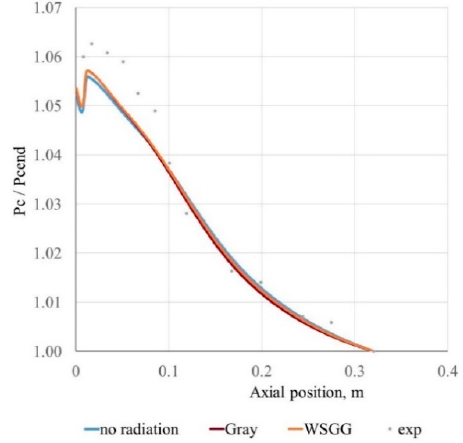
Figure 8. Normalized axial pressure distribution.